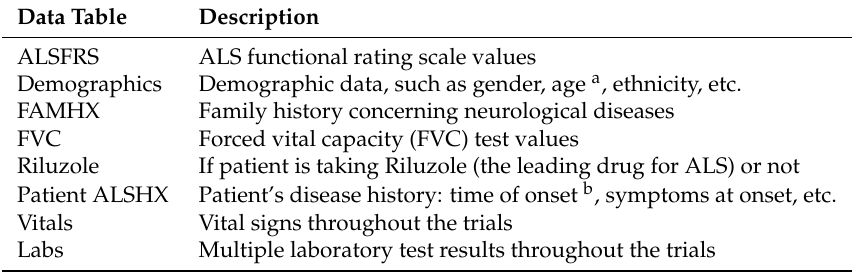
Table 1. Summary of data extracted from the PRO-ACT database and used in this study. Data